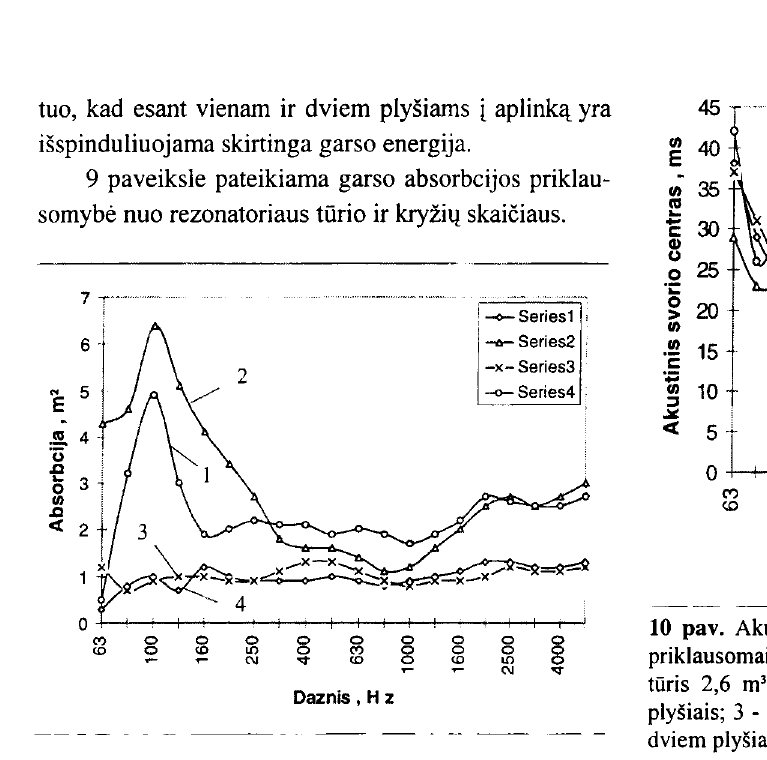
Fig 10. The frequency characteristics of an acoustic centre of gravity dependent on the volume of resonators and the number of slits: I - volume 2.6 m 3 with one slit; 2 - the same with two slits; 3 - volume 7.8 m 3 with one slit; 4- the same with two